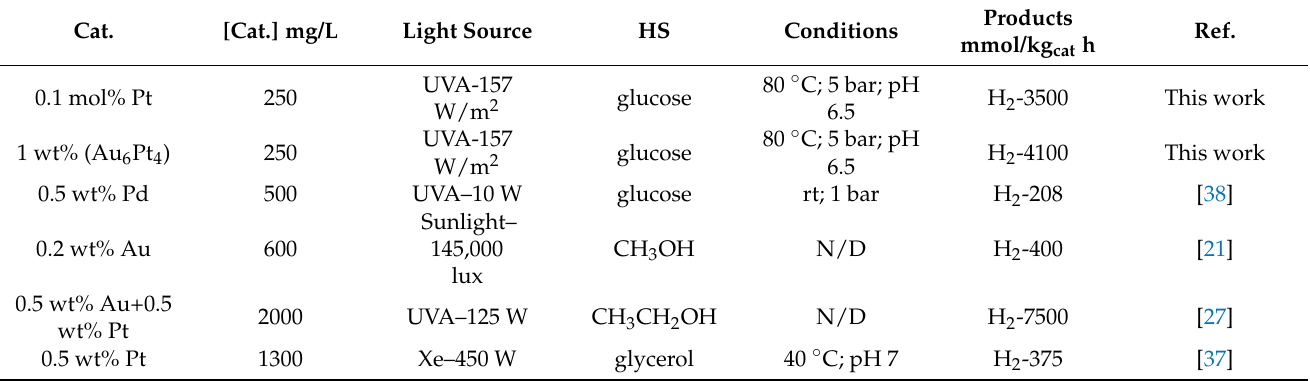
Table 6. Performance in the glucose photo-reforming of different photo-catalysts reported in